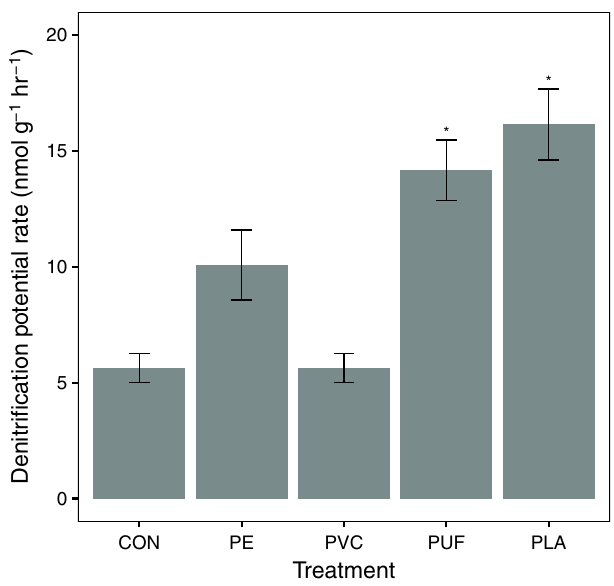
Fig. 6 Comparison of potential denitri fi cation rates. Potential denitri fi cation rate for each treatment in nmolg − 1 hr − 1 , calculated after the end of the experiment (day 17). Error bars are the standard error ( n = 6 per treatment) and asterix represent signi fi cant difference from the control ( p <0.05; Supplementary Table